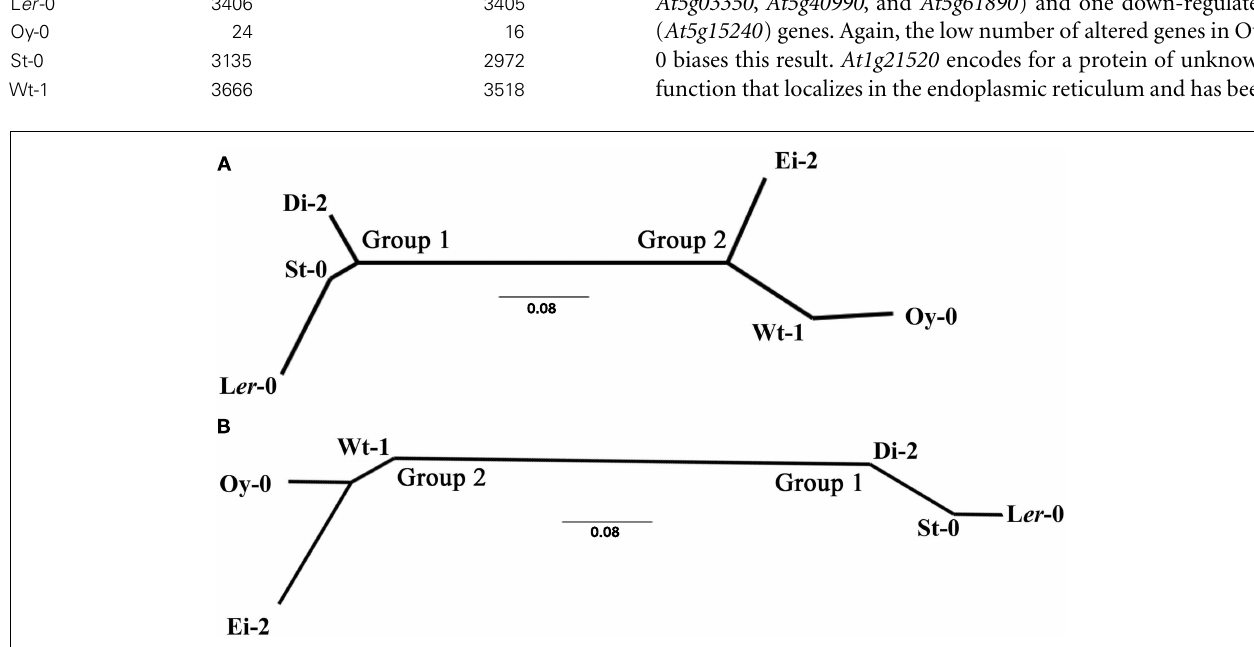
FIGURE 2 | Neighbor-joining dendrograms illustrating the similarity of ecotypes in their transcriptomic response toTEV- At 17b infection. (A) For up-regulated genes. (B) For down-regulated genes.